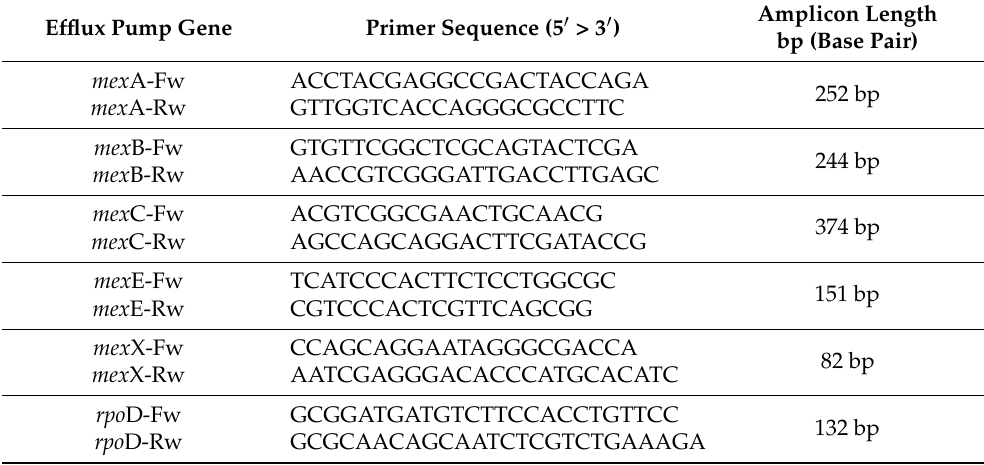
Table 4. The presentation of the efflux pump